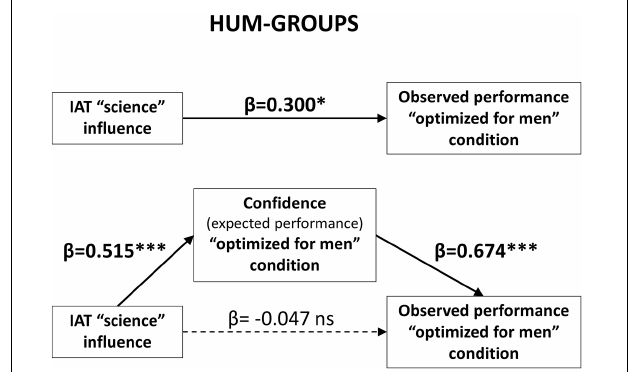
FIGURE 4 | Expected performance (confidence) mediates the effects of implicit gender-science associations. Mediation analysis was performed according to the 3-steps regression method described by Baron and Kenny (1986). First, we confirmed that the IAT “influence” scores predicted 3DMRT observed performance ( β = 0.300, p < 0.05). Then we confirmed that these scores also predicted confidence (expected performance; β = 0.515, p < 0.000) and that confidence predicted observed performance ( β = 0.650, p < 0.000). Finally, we simultaneously included the IAT “influence” and confidence scores as predictor variables of 3DMRT observed performance in a single regression equation. In this crucial step, only the confidence (expected performance) scores remained as strong predictors ( β = 0.674, p < 0.000) of observed performance, while the predictive value of IAT “influence”